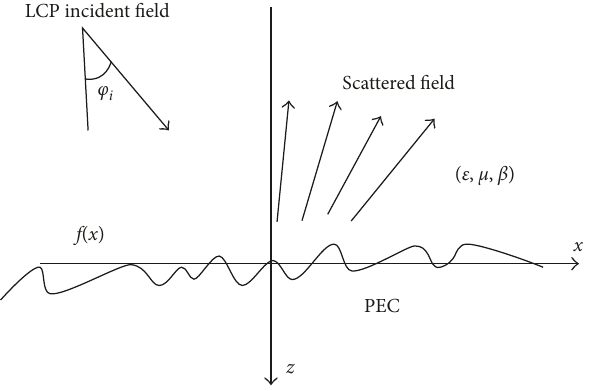
Figure 1: Scattering from a PEC rough surface in chiral